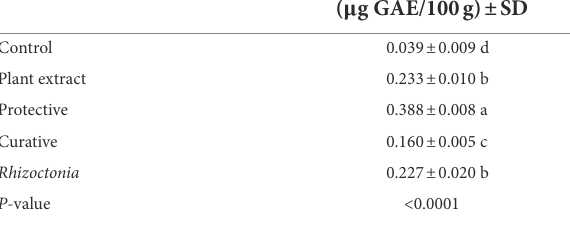
TABLE 5 Total phenolic components activities of all treatments used in this